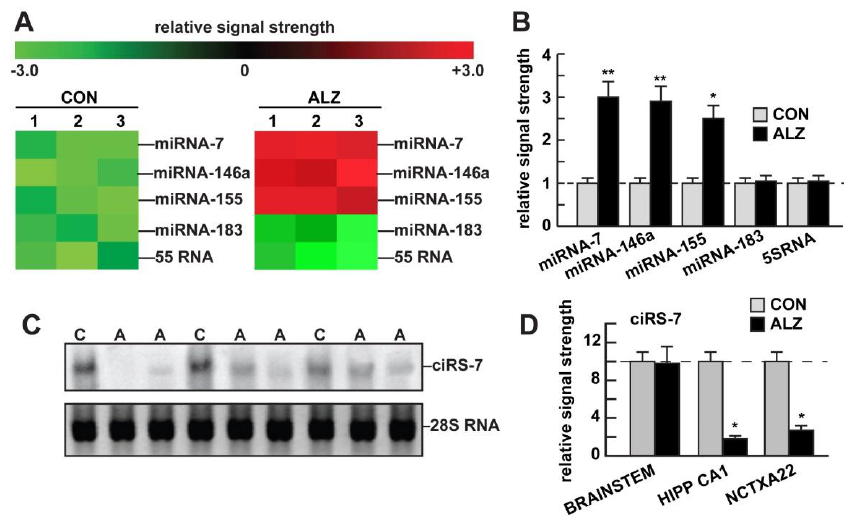
Figure 2. Increased miRNA-7 and deficits in ciRS-7 in AD. ( A ): up-regulated miRNA-7 in AD brain; lack of the miRNA-7 (ciRS-7) sponge by insufficient ciRS-7 suggests the miRNA-7 would be increased in the same brain regions where ciRS-7 is down-regulated as is observed; data in ( A ) quantified in bar graph format in ( B ); down-regulation of a family of miRNA-7-sensitive mRNA targets in the sporadic AD brain includes UBE2A; other mRNA targets may be involved; ( C ): detection of circRNA for miRNA-7 (ciRS-7) in sporadic AD and age-matched control hippocampal CA1 (control (CON) N = 4; AD (ALZ) N = 6]; in (C) the single upper ciRS-7 (~1400 nt) band contains ~70 selectively conserved miRNA-7 binding sites as previously described [8,10,11]; a lower 28S RNA served as an internal loading and reference control; all samples depleted of rRNA were treated with 50 units of RNaseR prior to electrophoresis see [8,10,23]); ( D ): AD ciRS-7 is significantly reduced to ~0.18-fold of control (CON) in AD (ALZ) hippocampal CA1 (HIPP CA1), to ~0.22 of control in the superior temporal lobe (Brodmann A22; NCTX A22) but not the brain stem (BRAINSTEM); this implicates loss of miRNA-7 sponge effects, and ambient up-regulation of miRNA-7 in at least two anatomical areas targeted by the AD process; there were no significant differences between age for control or AD tissues; (mean +/- one standard deviation (SD) = 71.6 ± 6.3 years ( N = 6; control); 73.5 ± 6.1 years ( N = 12; AD)); all AD cases were from moderate-to-advanced stages of AD; all postmortem intervals were 2.3 h or less; there were no significant differences in age, ApoE allele status, RNA quality (all RIN values were 8.1–9.0) or yield between the control or AD groups; Figure 1C has been redrawn in part from [10]; values in (B) and (D) are normalized to control levels; a dashed horizontal line at 1.0 or 10.0 is included for ease of comparison; (* p < 0.01, ANOVA); ** p < 0.001 (ANOVA).